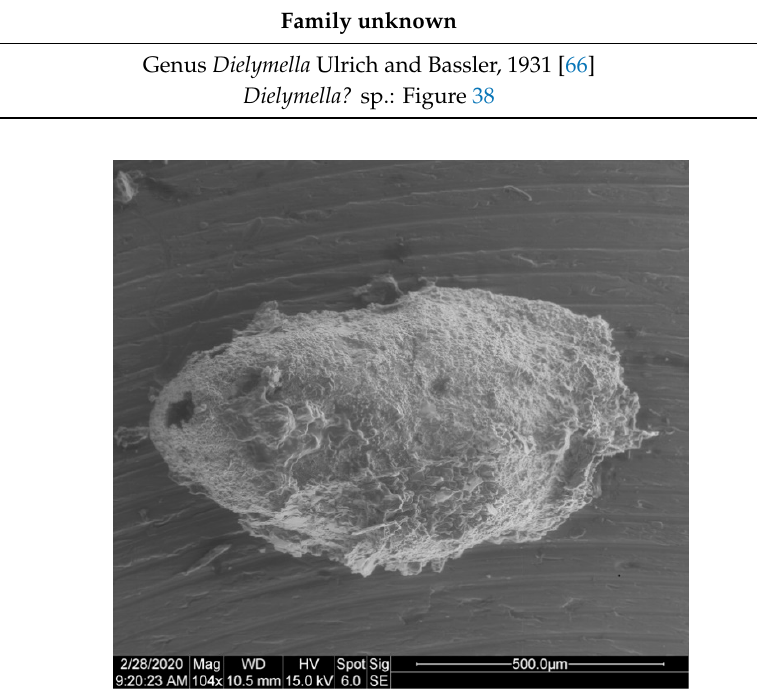
Figure 38. Dielymella? sp. Phosphatic steinkern of the right shield of an amplete bradoriid with a prominent dorsal cusp. IGM 3614 (44). Photo Credit: Mark McMenamin.